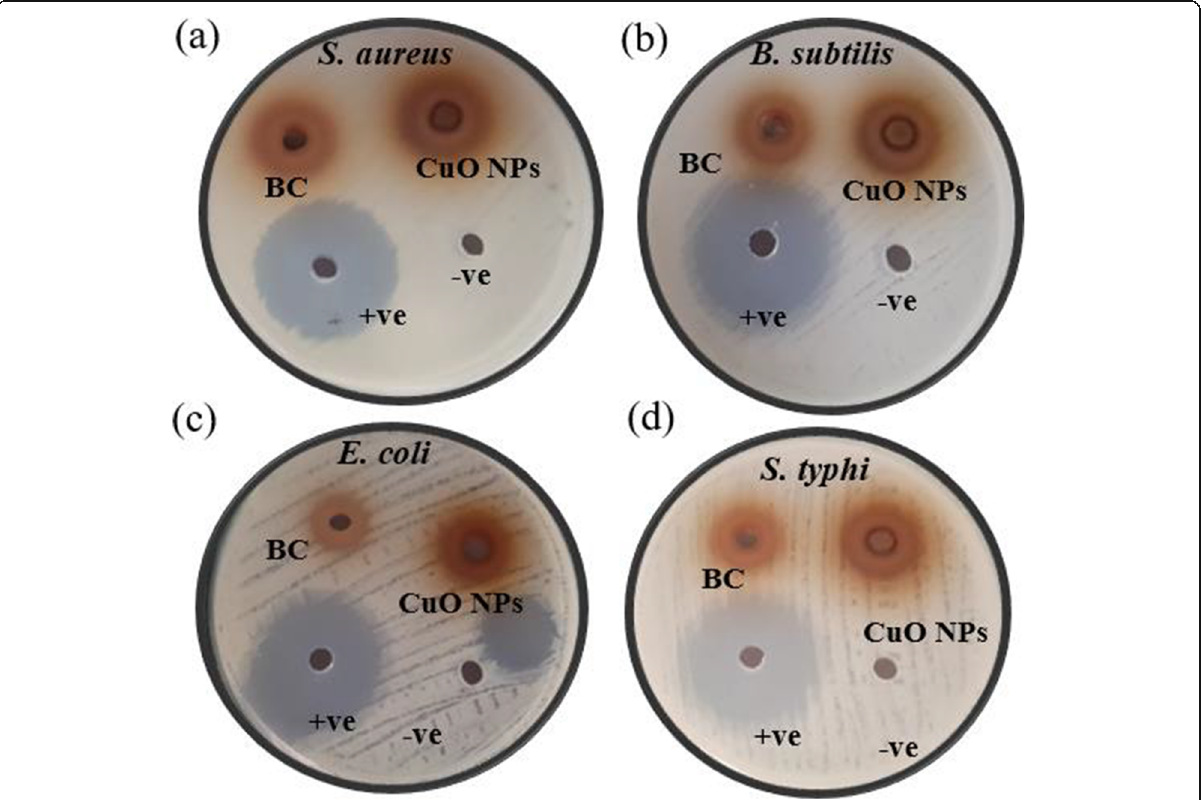
Fig. 8 Zone of inhibition of CuO NPs against various pathogenic bacterial strains